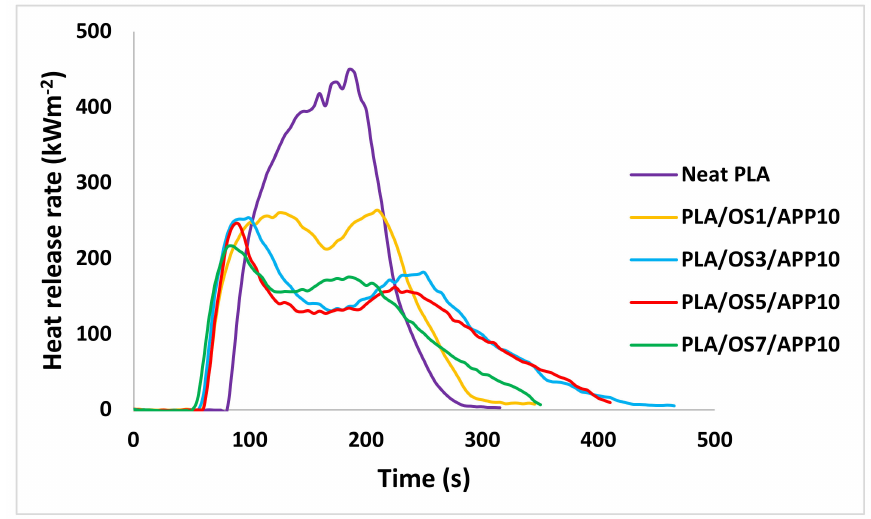
Figure 8. Heat release rate of samples (PLA = polylactic acid; OS = oxidized starch; APP = ammonium polyphosphate).